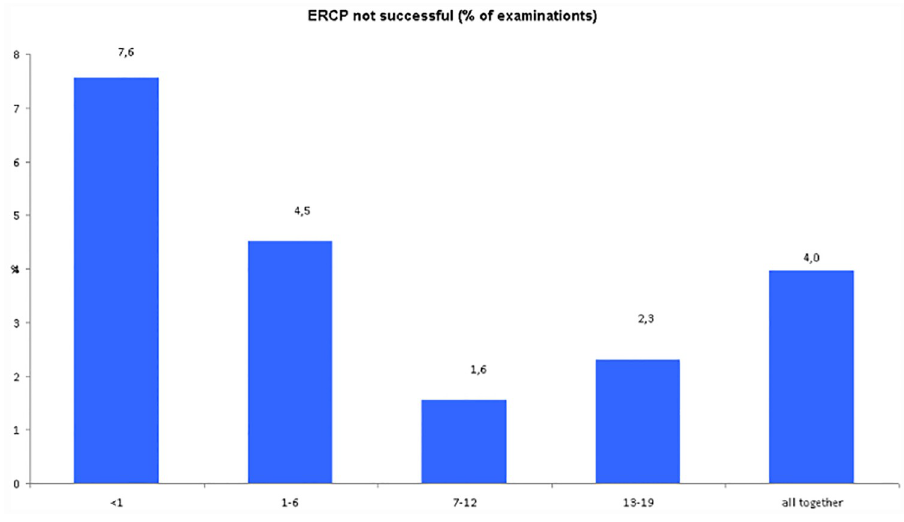
Fig 2. ERCP not successful